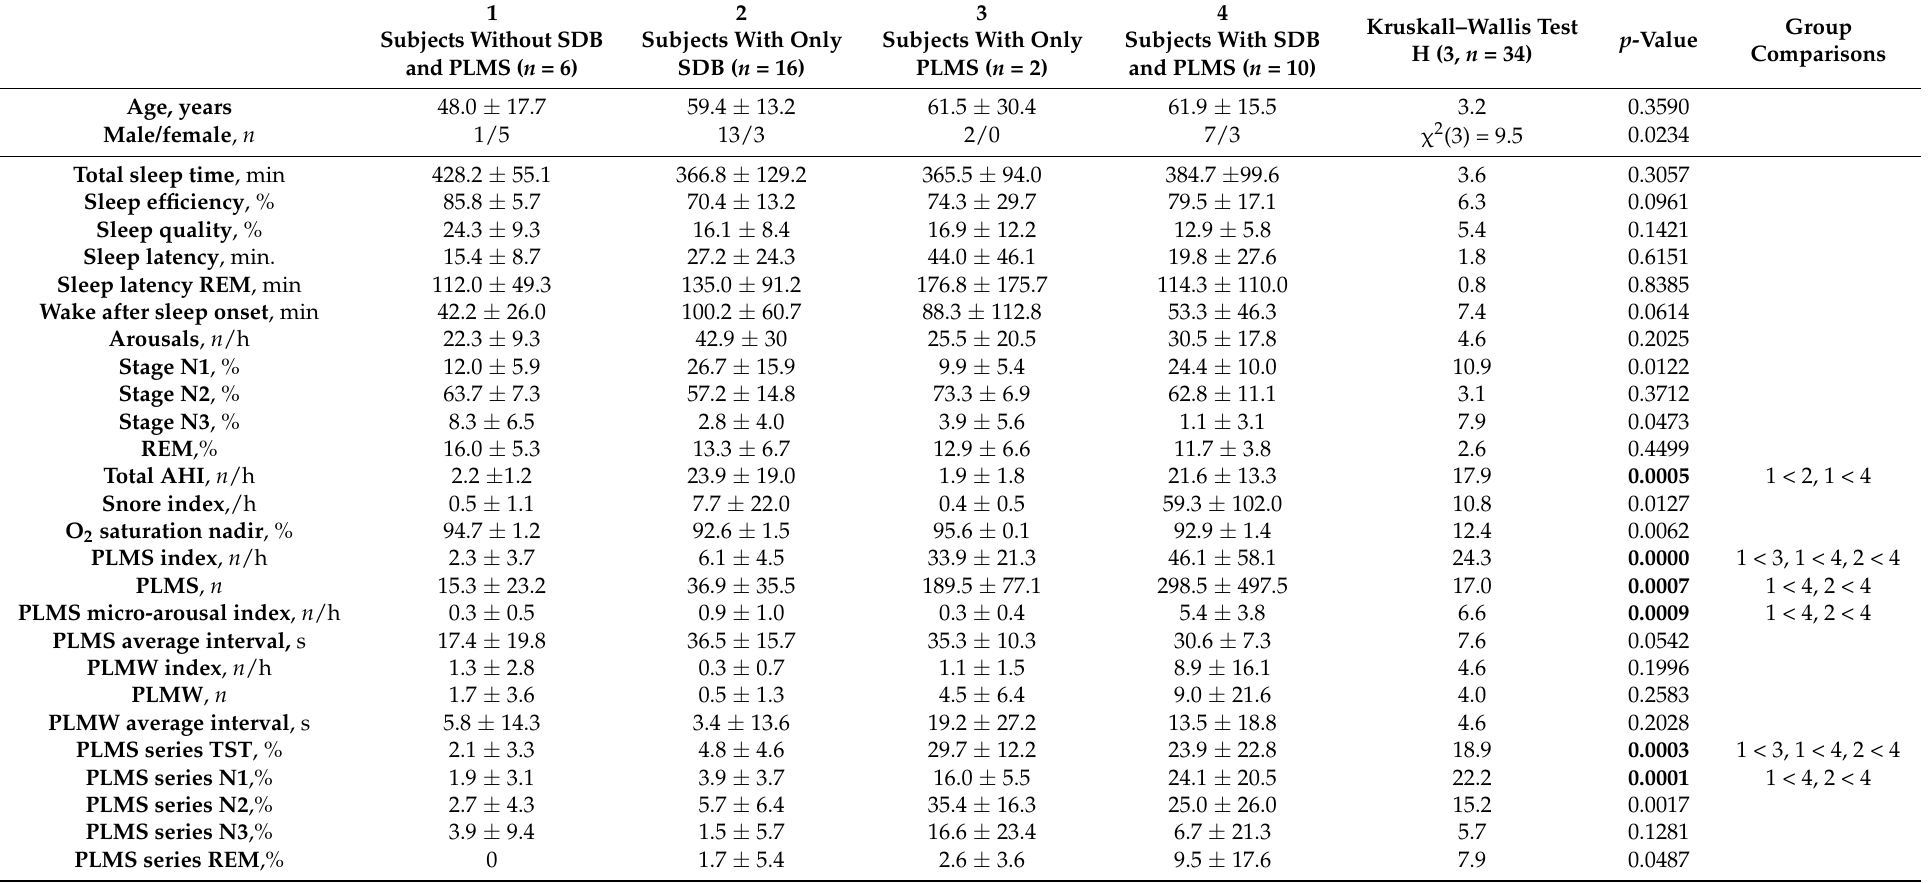
Table 3. Comparison across groups based on standard cut-offs of SDB and